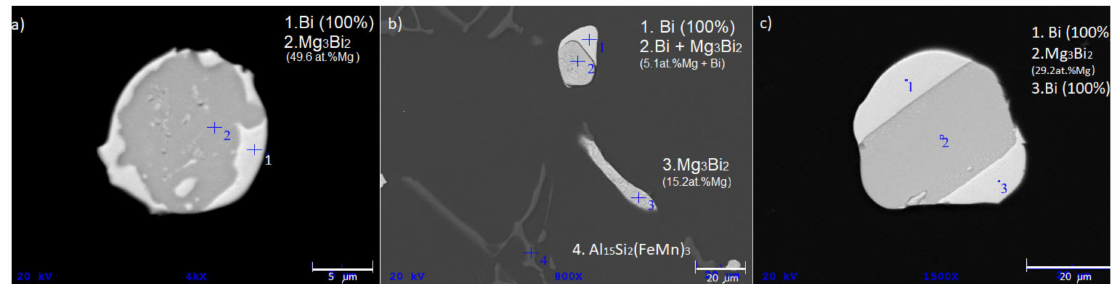
Figure 12. Micrographs of low-melting eutectic (Mg 3 Bi 2 + Bi) types in DSC remelted samples. ( a ) divorced eutectic (hypoeutectic composition Mg-Bi), ( b ) eutectic droplet (hypereutectic composition) and plate (hypoeutectic composition Mg-Bi), ( c ) hypoeutectic lamellar